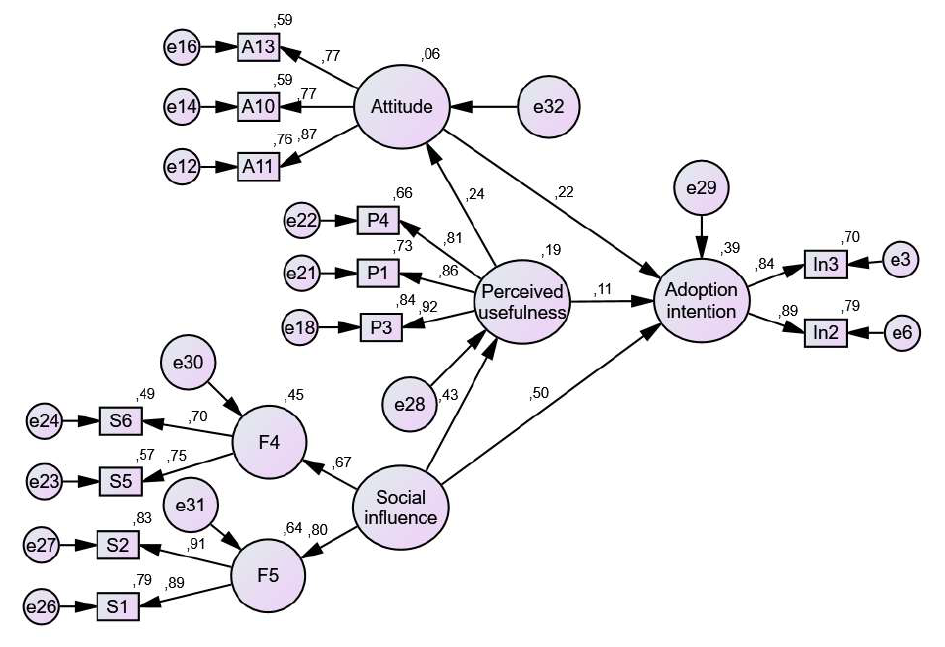
Fig. 2. Structural model of hypotheses